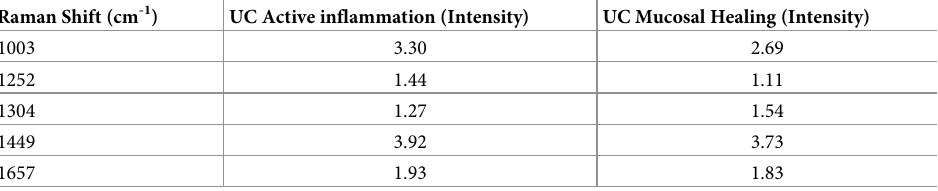
Table 2. Relative intensity of Raman shifts between UC MH vs active inflammation taken from